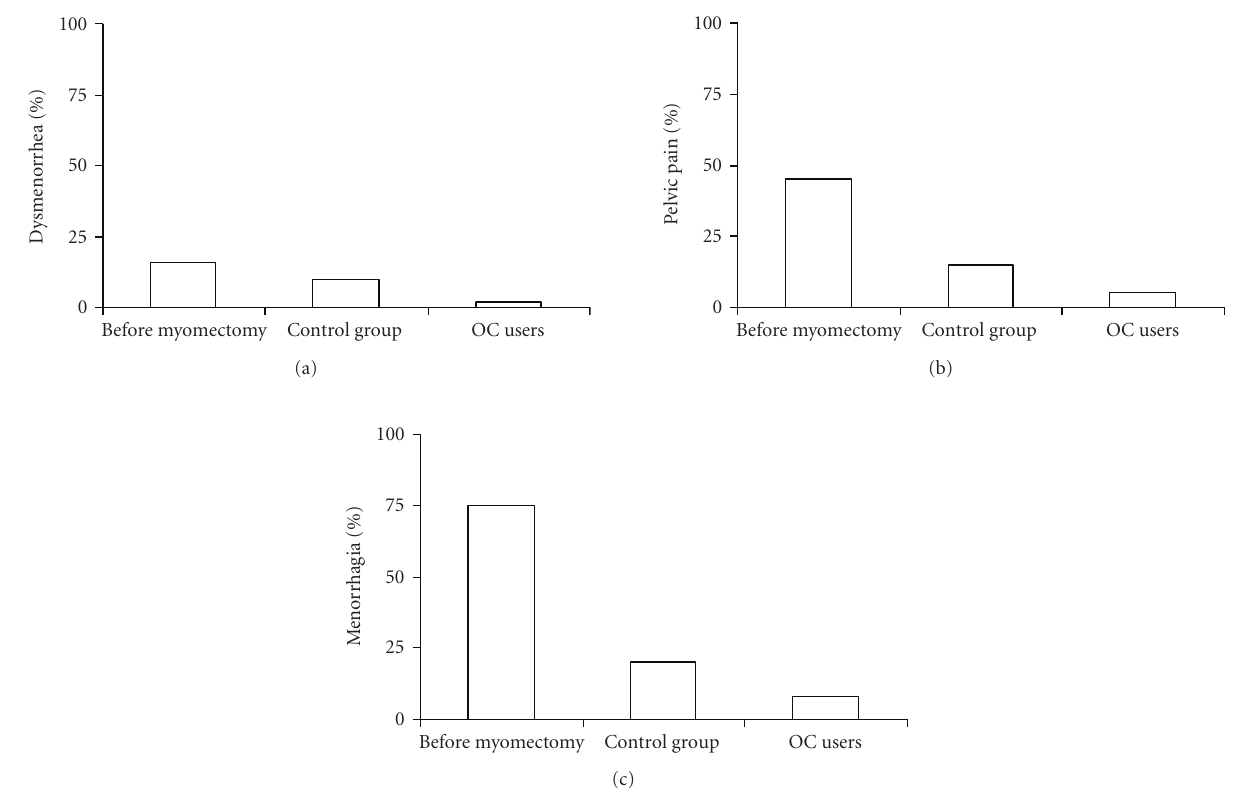
Figure 2: Improvement of symptoms (dysmenorrhoea, pelvic pain, menorrhagia) after myomectomy and OCs use. the main medication used to treat dysmenorrhea. Although several mechanisms underlying the dysmenorrheal pain relief attained by OC use have been reported, suppression of prostaglandin (PG) synthesis, which leads to reduced uterine contractions, represents one of the most probable pathways